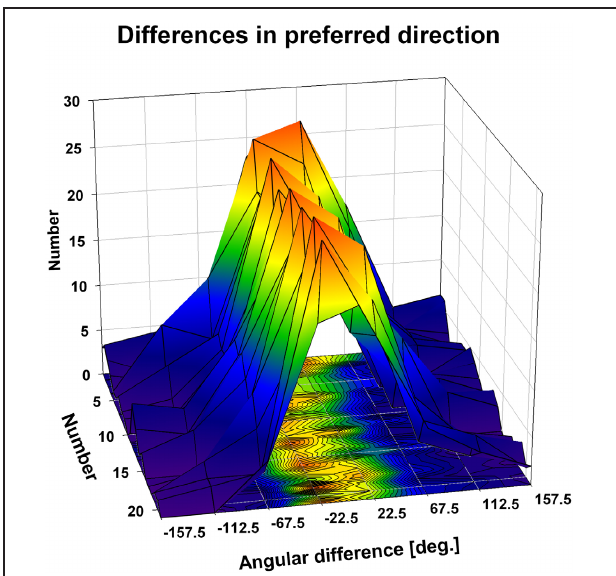
FIGURE 8 | Directional tuning as a function of disparity: population level. The three-dimensional plot shows color coded the distribution of the angular differences between preferred directions (PDs) of visual motion at different disparities. We computed for each neuron on a pairwise basis the angular difference between PDs obtained at different disparities in case the tunings were significant (Rayleigh test, p < 0 . 05). Given the seven different disparity values, this resulted in a maximum of 21 pairwise comparisons per neuron, represented by the y -axis of the x - y -base of the cube. Values were sorted for each condition (1–21) into 45 ◦ bins ( x -axis of the x - y -base). For all conditions, the angular differences clustered in the small value bins, i.e., around zero.